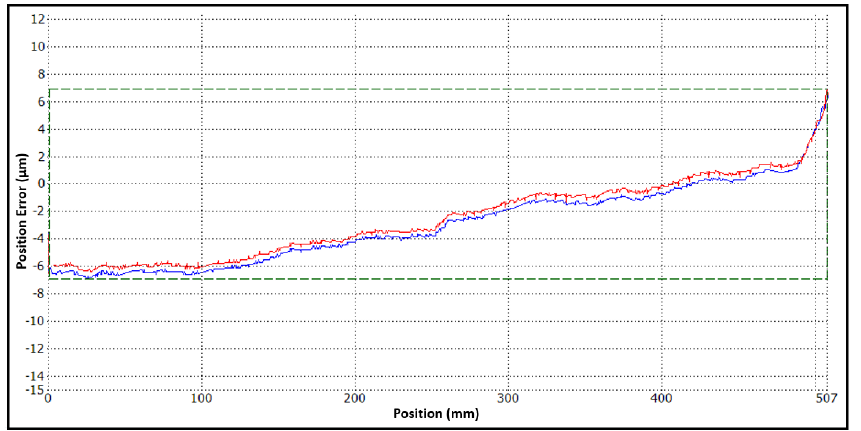
Figure 2. A typical plot of linear encoder error. (red and blue lines represent data collected when the measurement process is performed in both directions: forward (red) and backward (blue)).